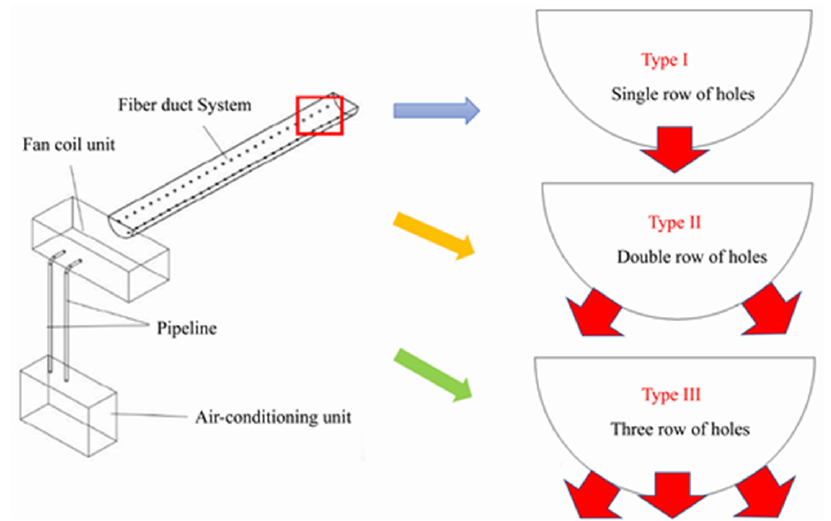
Figure 1. The schematic diagram of the split-fiber distribution air conditioner and openings. The sitting height of the people in the room was 1100 mm, and the total height of the desk and computer was the same as the height of the human body. The height of the air outlet of the split-fiber air conditioner was 1200 mm, the dimensions of length × width = 50 mm × 50 mm, and the heat flux densities of the computer, the human body, and the lamp were 150 W/m 2 , 47 W/m 2 , and 61 W/m 2 , respectively. The overall model of the room is shown in Figure